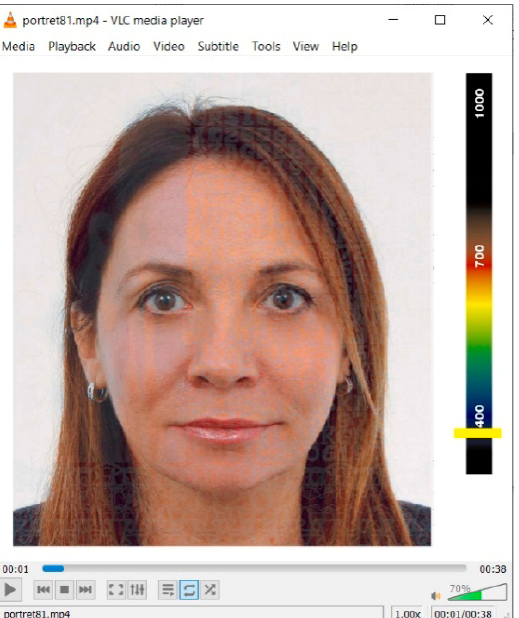
Figure 15. Blockage at 400 nm.